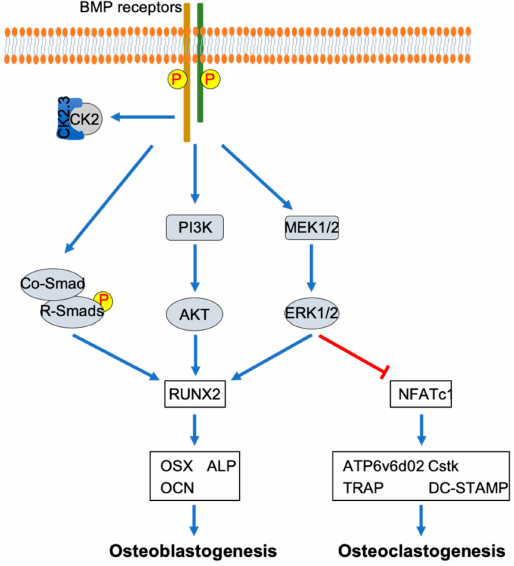
Figure 11. Di ff erential mechanisms of CK2.3 in osteoblastogenesis and osteoclastogenesis. CK2.3 activates SMAD, AKT, and ERK, resulting in the upregulation of the osteoblastic master transcription factor RUNX2, which promotes osteoblastogenesis. On the other hand, CK2.3 activates ERK, resulting in the downregulation of the master transcription factor NFATc1, which inhibits